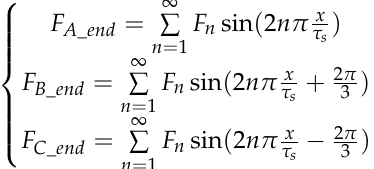
Figure 3. Analysis of air gap flux density and its harmonic generated by armature winding: ( a ) Air gap magnetic density ( b ) Harmonic content in air gap.